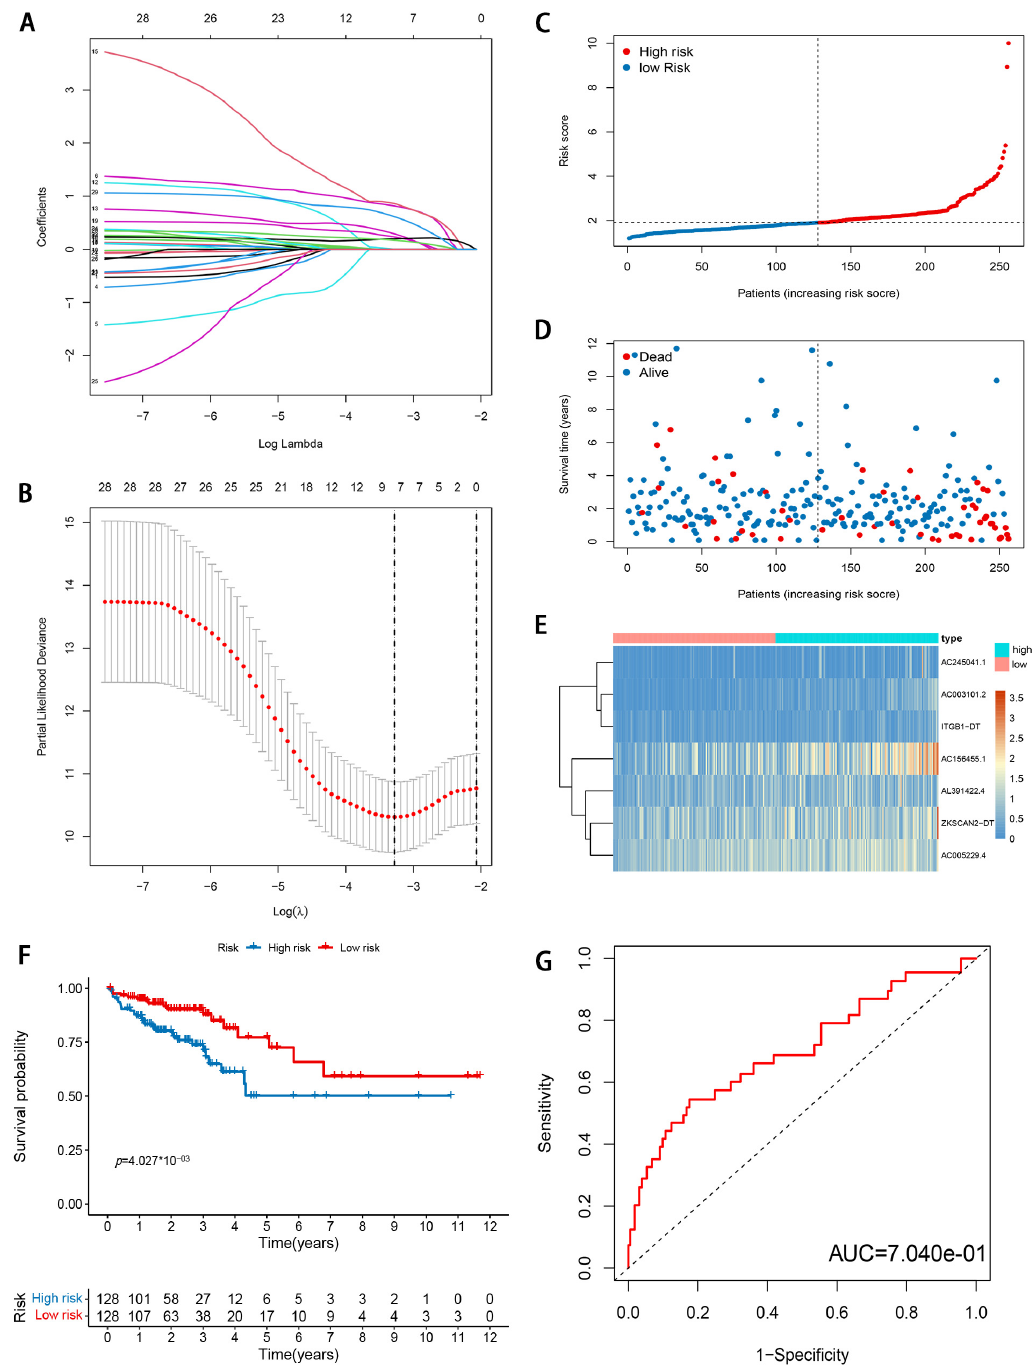
Figure 4. Development and evaluation of m6A-modified lncRNA signature related to OS in TCGA training cohort. ( A ) LASSO coefficient profiles of seven prognosis-associated lncRNAs. ( B ) Tenfold cross-validation for tuning parameter selection in the LASSO model. ( C ) The risk score distribution. Blue dots represent risk score for low-risk patients; red dots represent risk score for high-risk patients. ( D ) The relationship between survival status and risk score. The abscissa represents the number of patients, and the ordinate is the risk score. Red dots represent dead patients, blue dots are living patients. ( E ) Heatmap showing the expression profile of the seven signature lncRNAs. ( F ) Kaplan–Meier method was used to plot the RFS curve for the high-risk score and low-risk score groups. ( G ) ROC curves and AUCs of the 7-gene